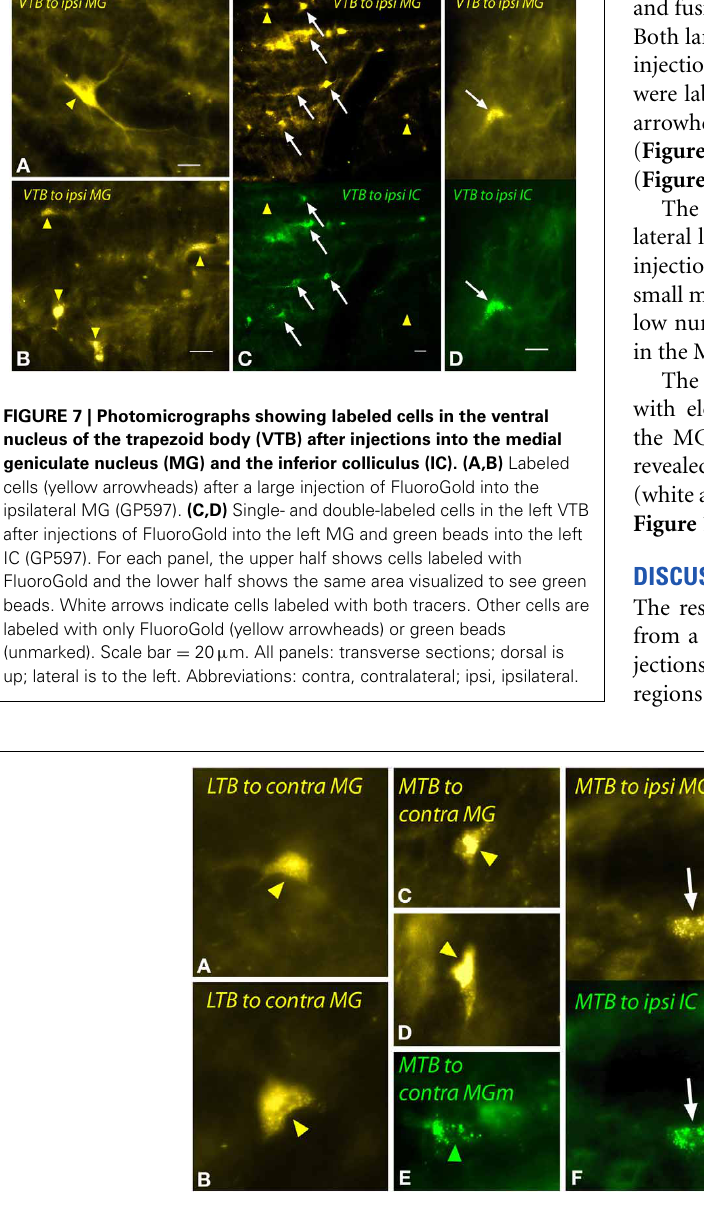
medial subdivision (MGm) (GP689). (F,G) Single- and double-labeled cells in the left MTB after injections of FluoroGold into the left MG and green beads into the left IC (GP597). For each panel, the upper half shows cells labeled with FluoroGold and each lower half shows the same area visualized to see green beads. White arrows indicate cells that are labeled with both tracers. Scale bar = 20 µ m and applies to all panels. Transverse sections; dorsal is up; lateral is to the right (A–D) or left (E–G) . Abbreviations: contra, contralateral; ipsi,